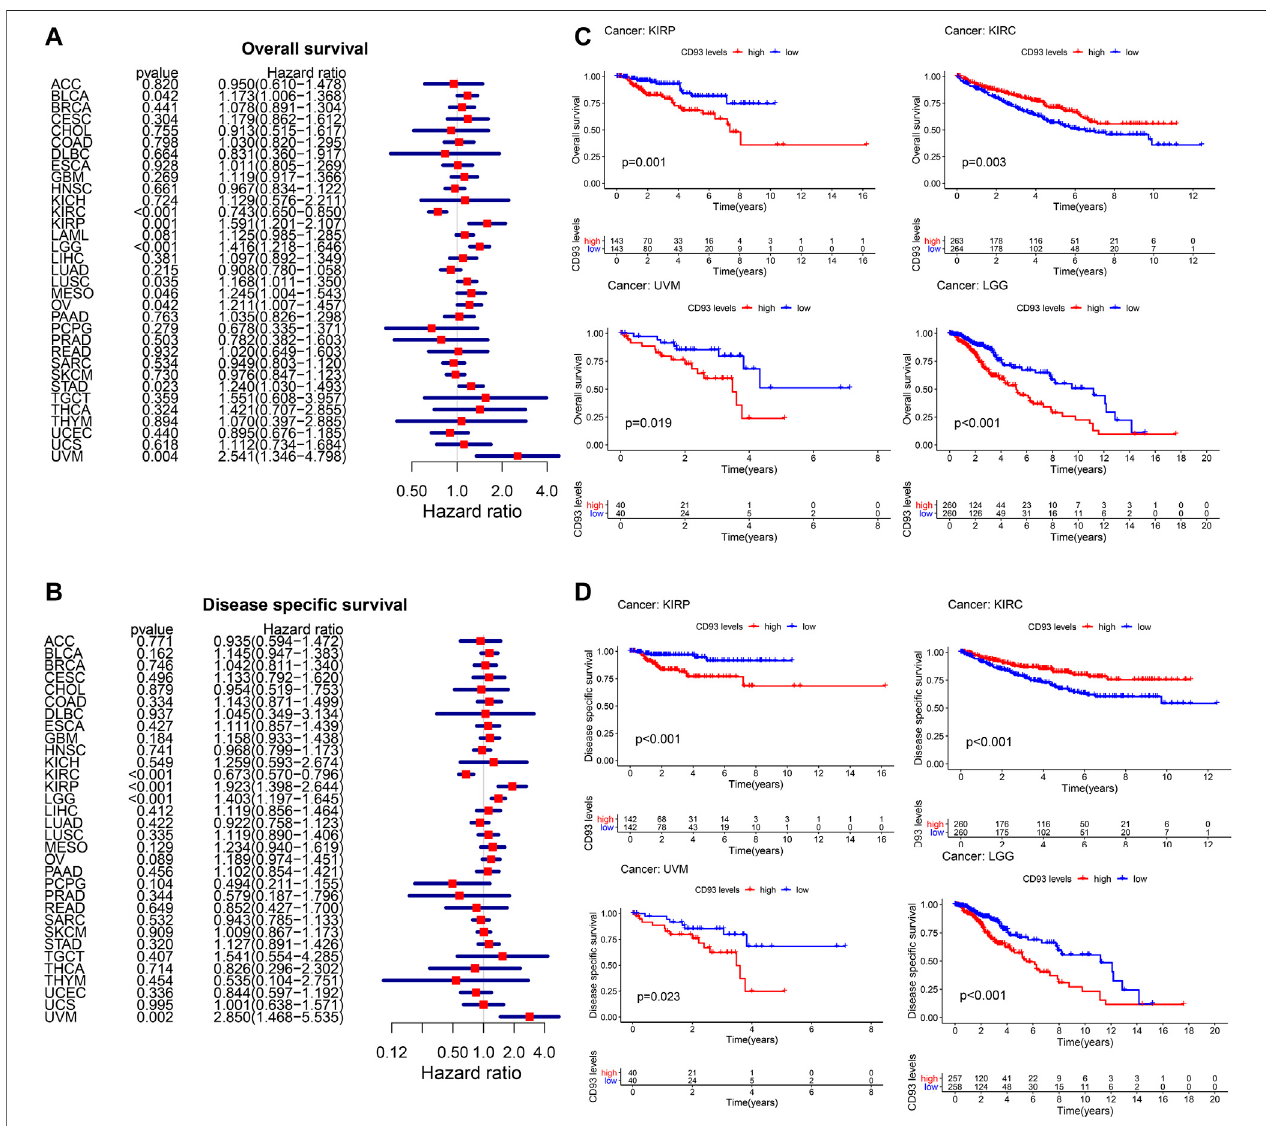
FIGURE 2 | Relationship between CD93 expression and patient prognosis. (A,B) Correlation between the expression of CD93 and overall survival (OS) and disease-speci fi csurvival(DSS)inmultipletumortypesbasedonTheCancerGenomeAtlas(TCGA). (C) DifferenceintheOSbetweentheCD93highand lowexpression groupsinfourcancertypes(KIRP,KIRC,UVM,andLGG). (D) DifferenceintheDSSbetweentheCD93highandlowexpressiongroupsinfourcancertypes(KIRP,KIRC, UVM, and